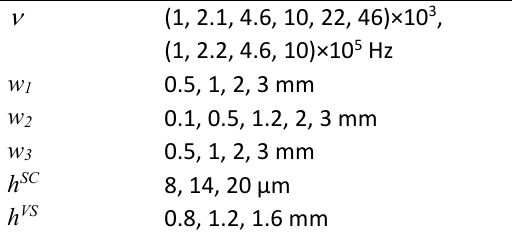
Tab.3: Parameter combinations.